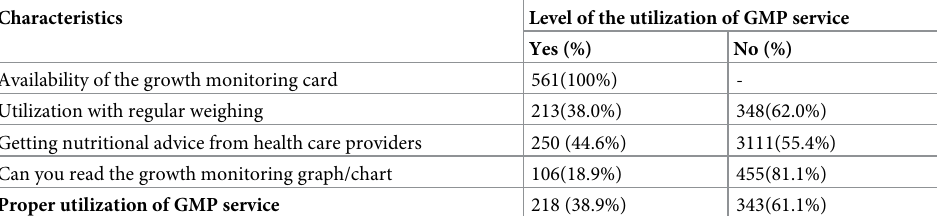
Table 5. Utilization of growth monitoring and promotion service among 0-23-month-old children in Banja Dis- trict, Northwest Ethiopia, 2020 (n = 561).